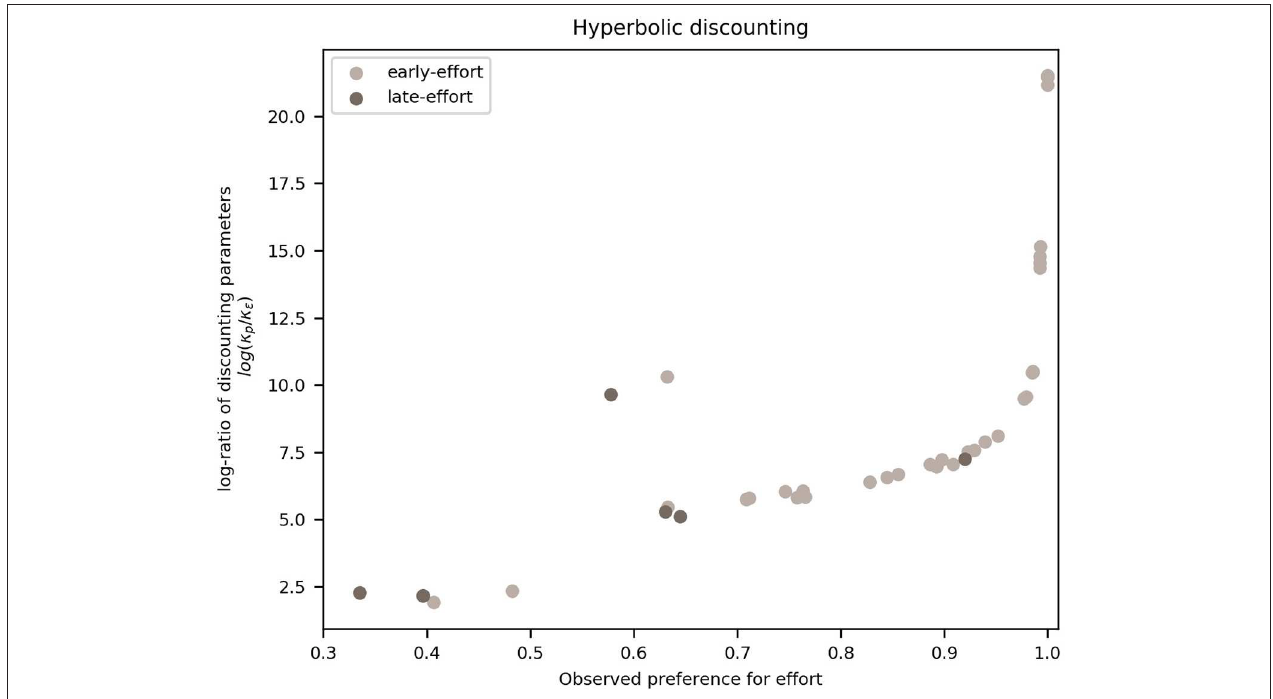
FIGURE 6 | Frequency of effort vs. log-ratio of probability to effort discounting parameters. Each dot represents a participant, divided into late-effort (dark dots) and early-effort (light dots). We plot the frequency with which a participant chose the effortful action (until reaching the goal of a mini-block) on the x-axis and the log-ratio of the HSA model (hyperbolic discounting applied to the “effort:stack/probability: add” model variant) parameters for probability to effort discounting, i.e., κ p to κ ǫ , on the y-axis (log-scale for